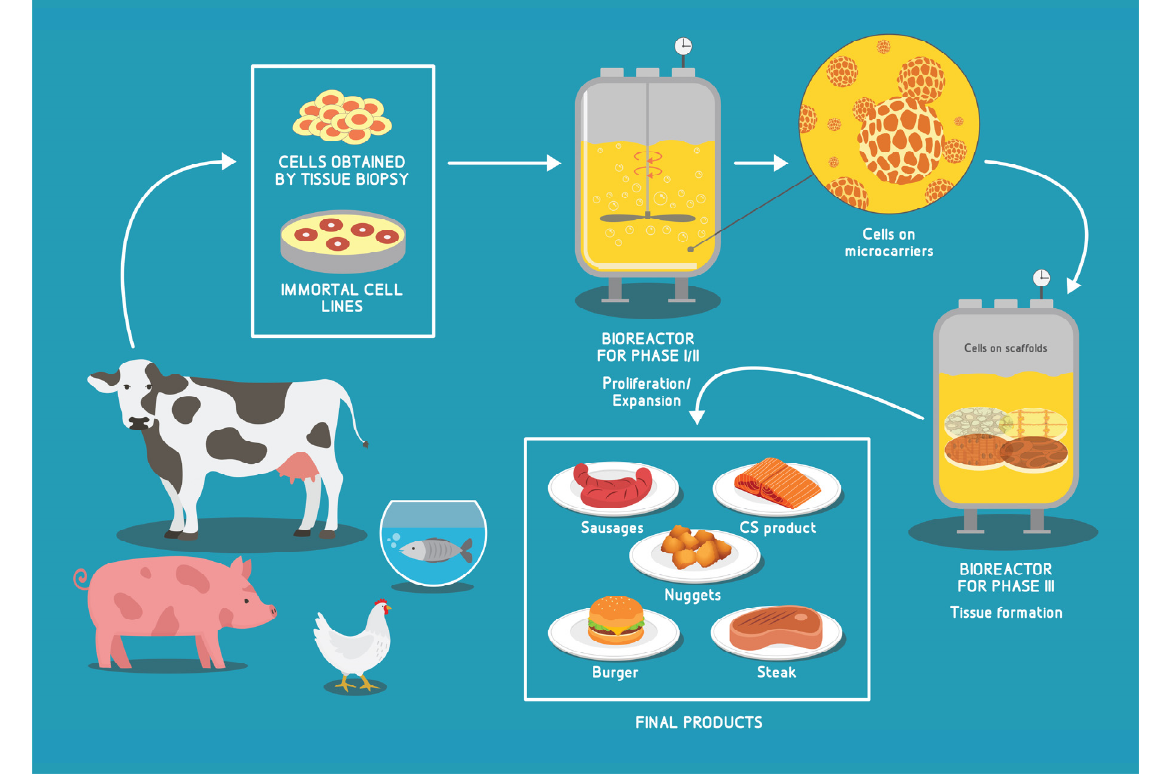
Figure 1. Simplified schematic of the vertebrate cell-based CM/CS